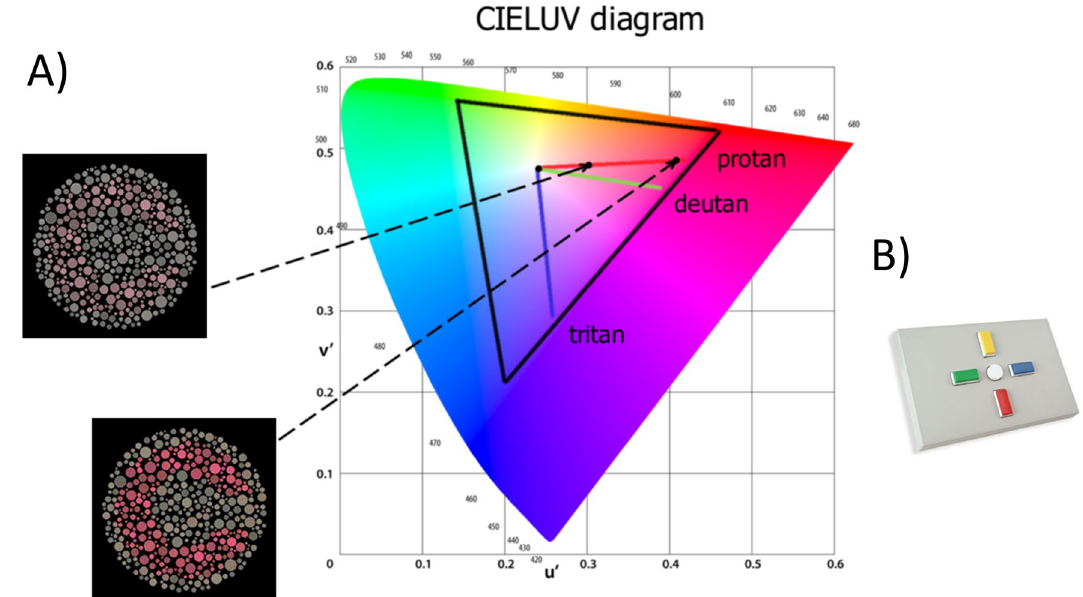
Figure 1. ( A ) Illustration of the chromatic targets, Landolt “C”, embedded in the luminance noise background (image source: Cambridge Colour Test Handbook (2000, p. 4) and the Protan, Deutan, and Tritan vectors in the CIE 1976 u ′ v ′ chromaticity diagram (image source: Cambridge Research Systems Ltd., https:// www. psych ophys ics. uk/ colour- discr imina tion/). Permission has been obtained from Prof. John D. Mollon, who holds the copyright of the CCT. ( B ) Response box RB-540 provided by Cambridge Research Systems Ltd. and used in the experiment. Four choices are available to indicate position of the Landolt “C” opening on a given trial: up, down, right and